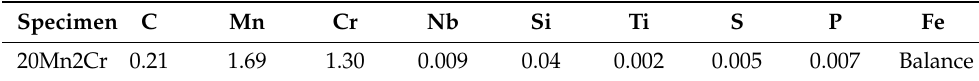
Table 1. Chemical composition of the new cold-rolling steels (wt%) [26]. Specimen